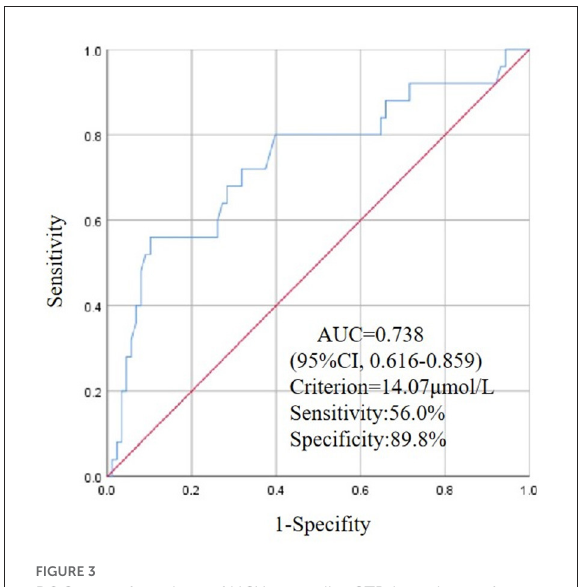
FIGURE3 ROC curve for values of HCY to predict CTD in patients of first-attack